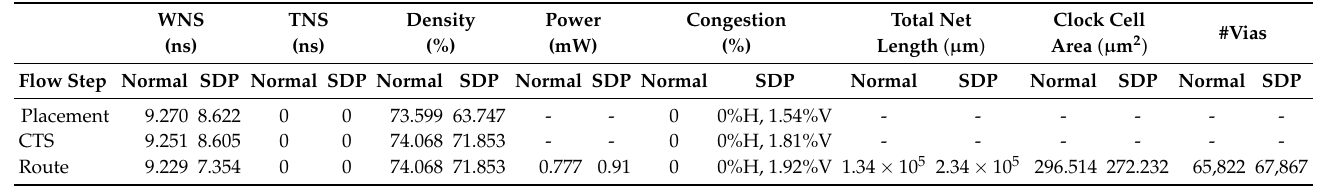
Table 1. Summary of Results for RFile Design, Core Area W = 179.6 µ m, L = 179.55 µ m.